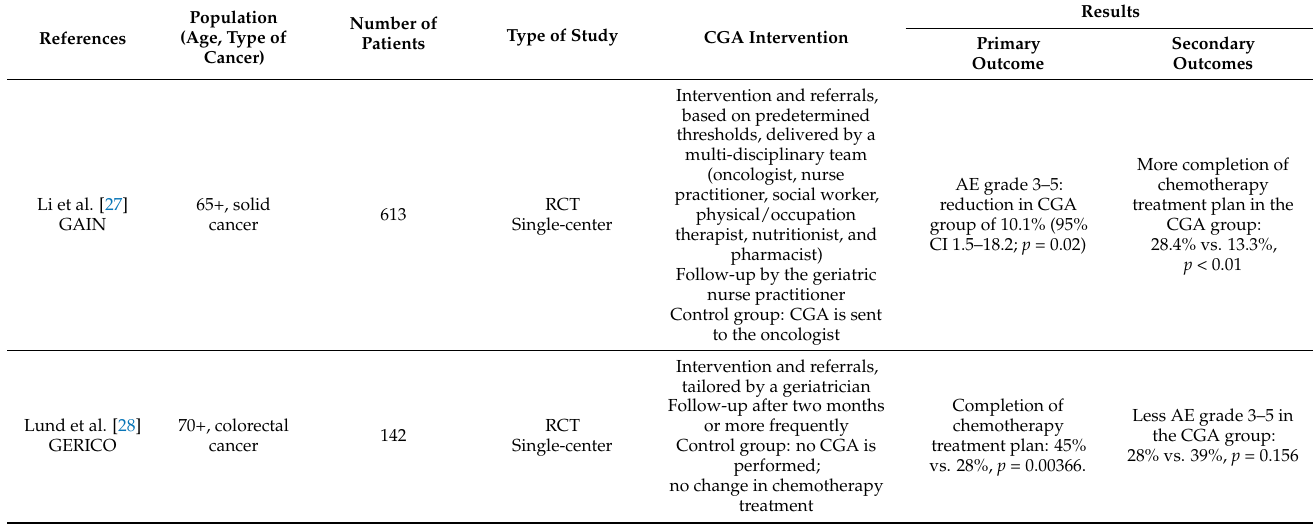
Table 1. Comparison of the three randomized trials on global CGA-based